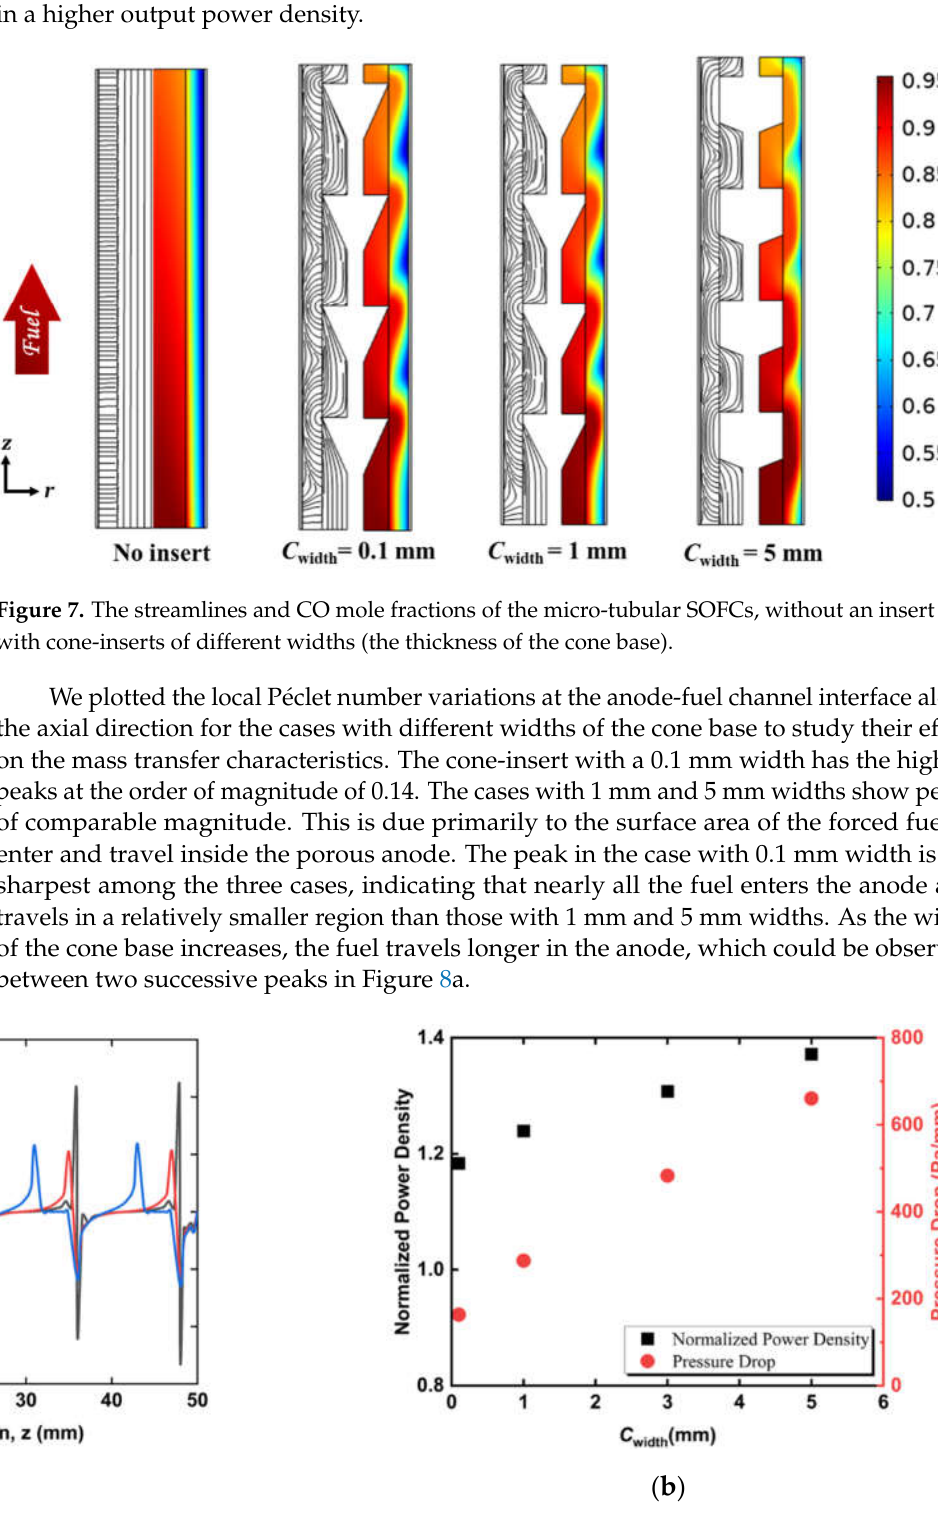
Figure 8. The influence of cone-insert of different widths on ( a ) local Péclet number variation in the anode-fuel channel interface along the axial direction, ( b ) the output power density and gas-phase pressure drop of micro-tubular SOFC.